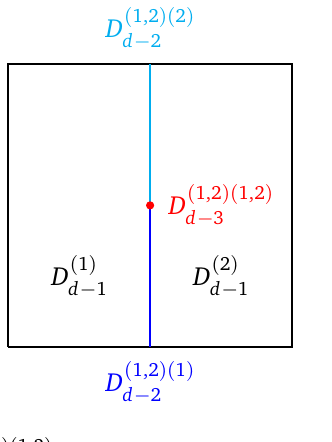
Figure 8: A 2-morphism D p 1,2 qp 1,2 q between 1-morphisms D p 1,2 q , p 1 q d ´ 3 from D p 1 q to D p 2 q d ´ 1 d ´ 1